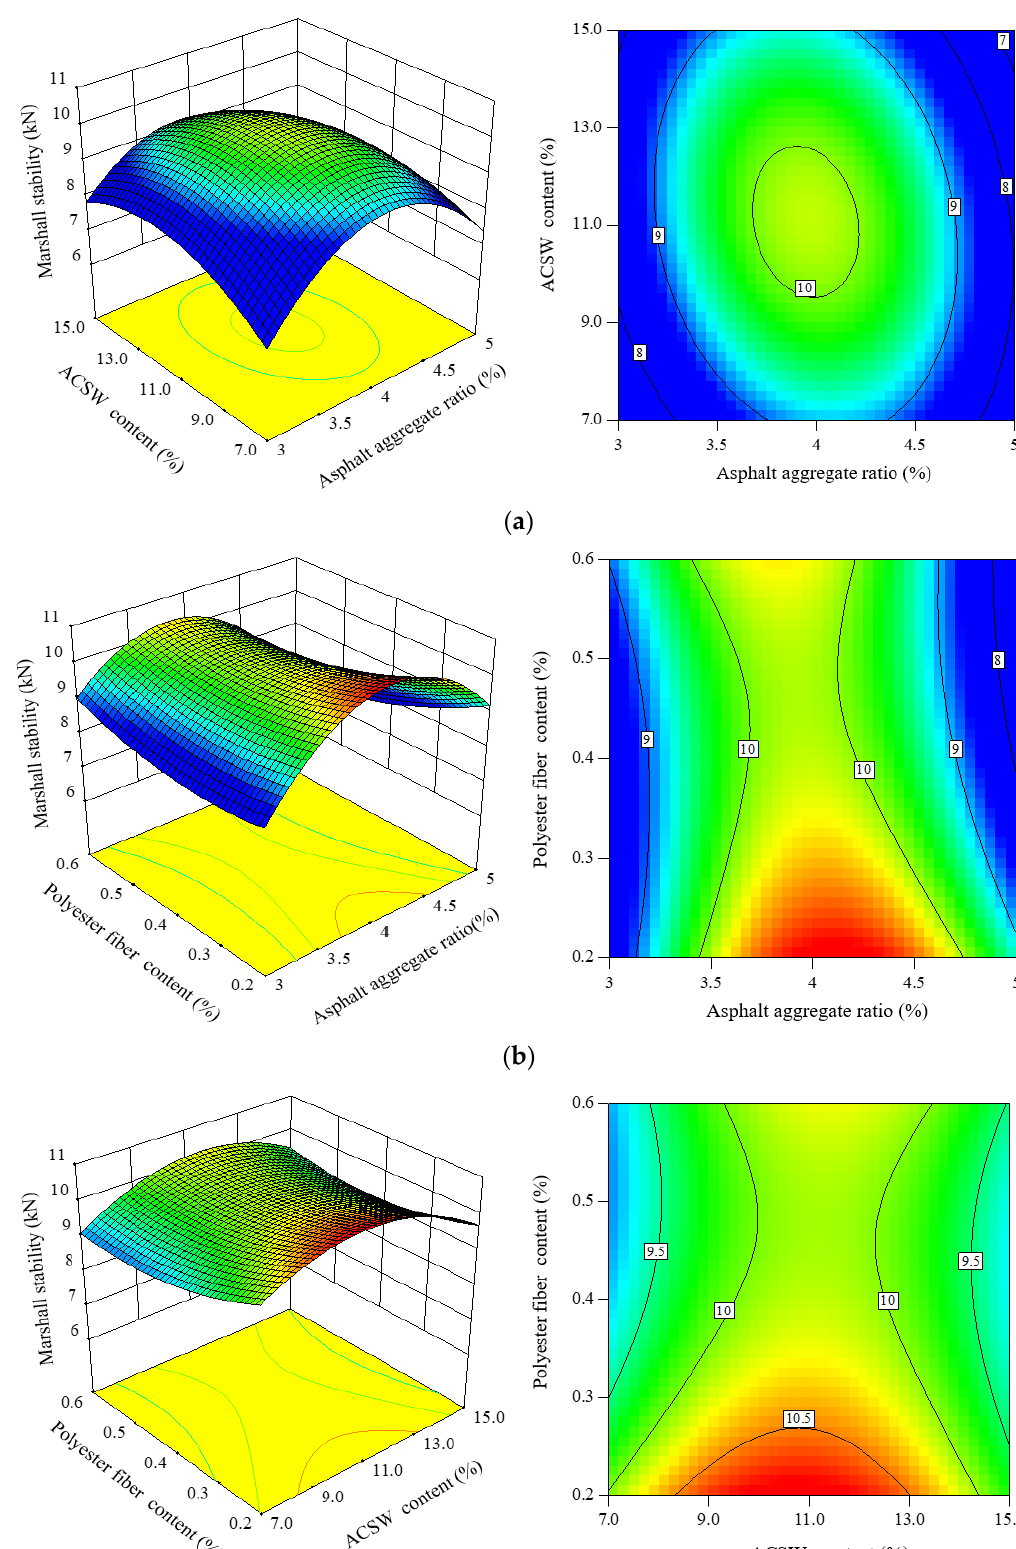
Figure 7. Three- and two-dimensional CCC response maps among three factors on MS : ( a ) factors: asphalt aggregate ratio and ACSW content; ( b ) factors: asphalt aggregate ratio and polyester fiber content; and ( c ) factors: ACSW content and polyester fiber content.